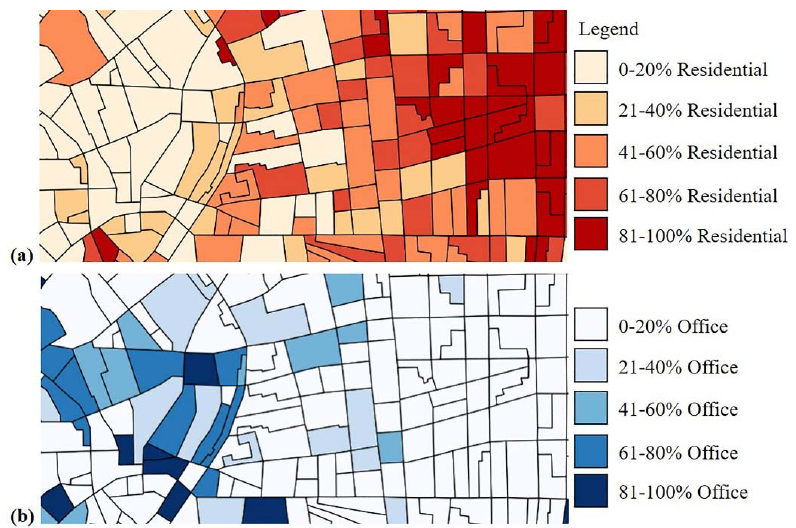
Figure 7. Characterization of each Census Unit by percentages of ( a ) residential and ( b ) office vol-